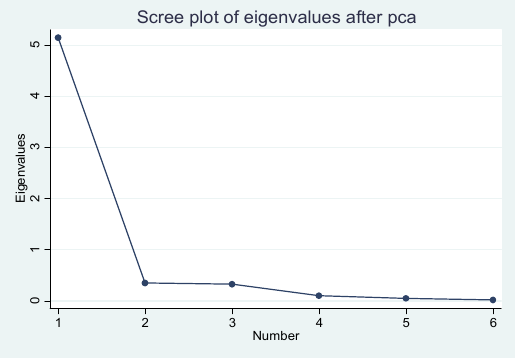
Fig. 1. Screen plot of eigenvalues